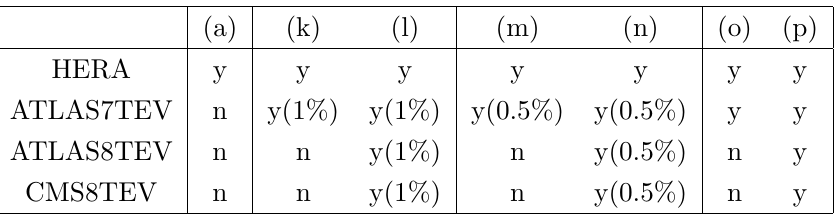
Table 7 . Overview of the (cid:12)ts run with HERA-only as a baseline including the normalized ATLAS 7 TeV along with the other data sets. For each (cid:12)t, we indicate which measurements from ATLAS and CMS has been included, whether an uncorrelated uncertainty has been added to the (cid:31) 2 (in brackets unless it is set to